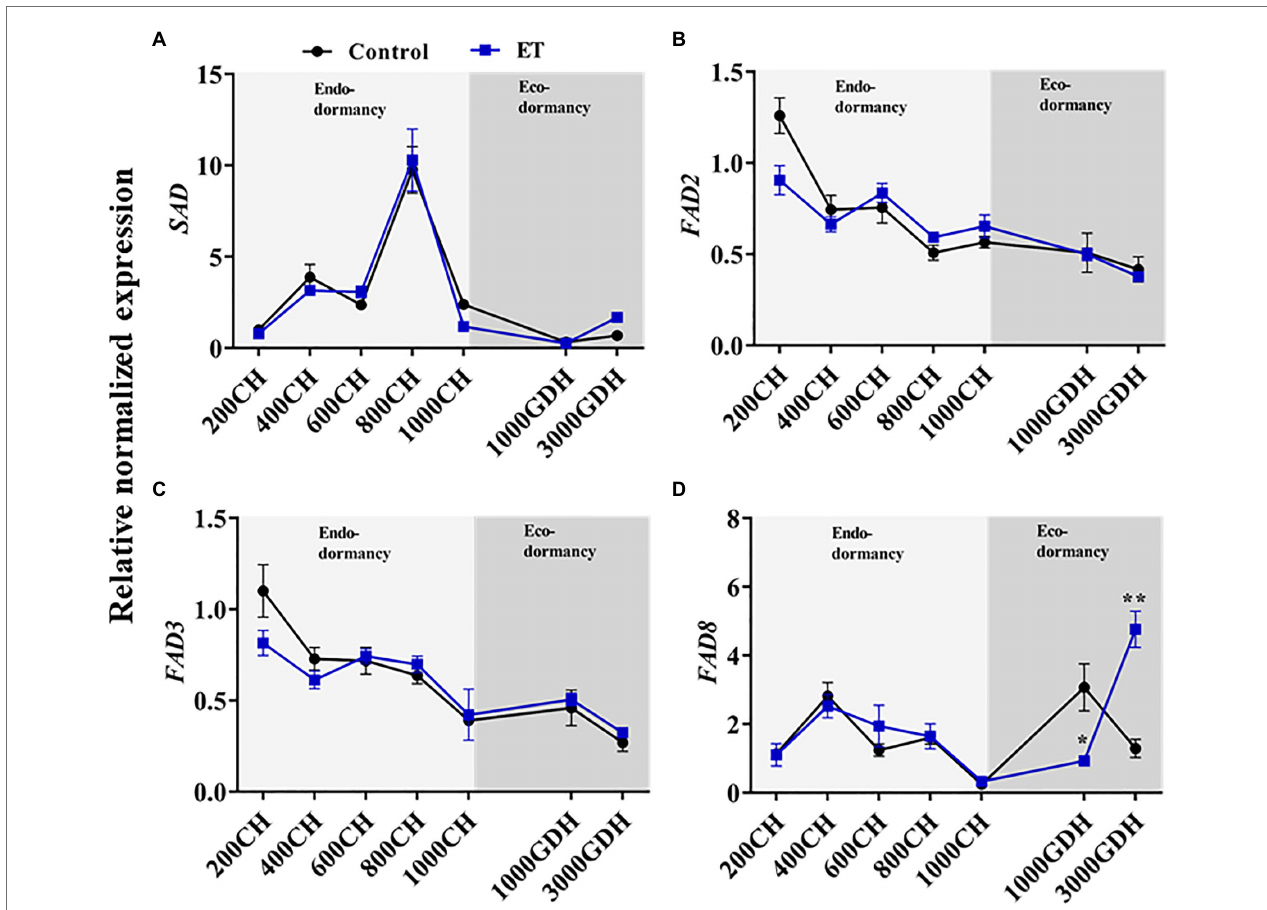
FIGURE 5 | Alterations of the fatty acid metabolism-related genes during the dormancy by the ethephon (ET) treatment in peach “Red haven” floral buds. Stearoyl- acyl carrier protein desaturase ( SAD; A) , fatty acid desaturase 2 ( FAD2 , B) , fatty acid desaturase 3 ( FAD3 , C) , and fatty acid desaturase 8 ( FAD8 , D) . Data represent the mean ± SEM for n = 3. Asterisks indicate significant differences between the control and ET-treated plant buds at different chilling hours (CH) and GDH; ∗ p < 0.05; and ∗∗ p <